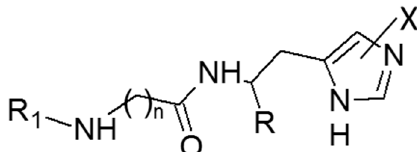
Figure 1. The general molecular formula of the tested compounds. Table 1. Considered carnosine derivatives 1 – 10 and their CA activating properties against human CA isoforms hCA I, II, VA and IX, by a stopped-flow CO 2 hydrase assay. Histamine 11 was used as reference standard activator.